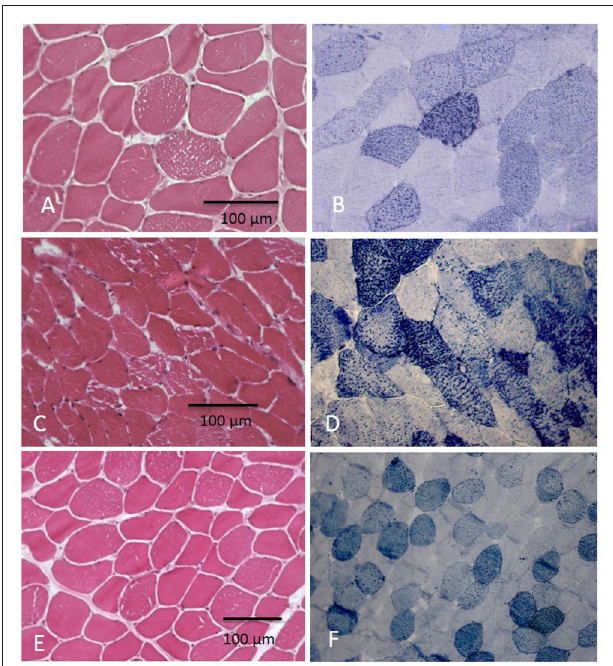
FIGURE 1 | Muscle biopsy showed vacuolization in myofibers at H&E with increase of lipid content at Sudan Black at different grades: in few fibers in pt. 5 (A,B) and in several fibers in pts 5 and 6 (C–F)